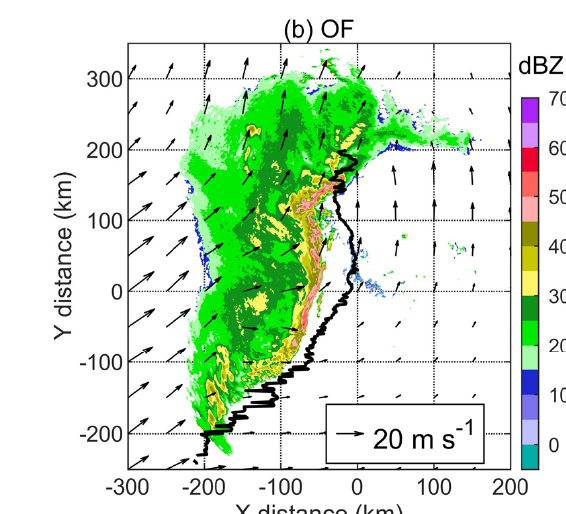
Figure 4. Wind field from ERA5 reanalysis data at 09:00 UTC.